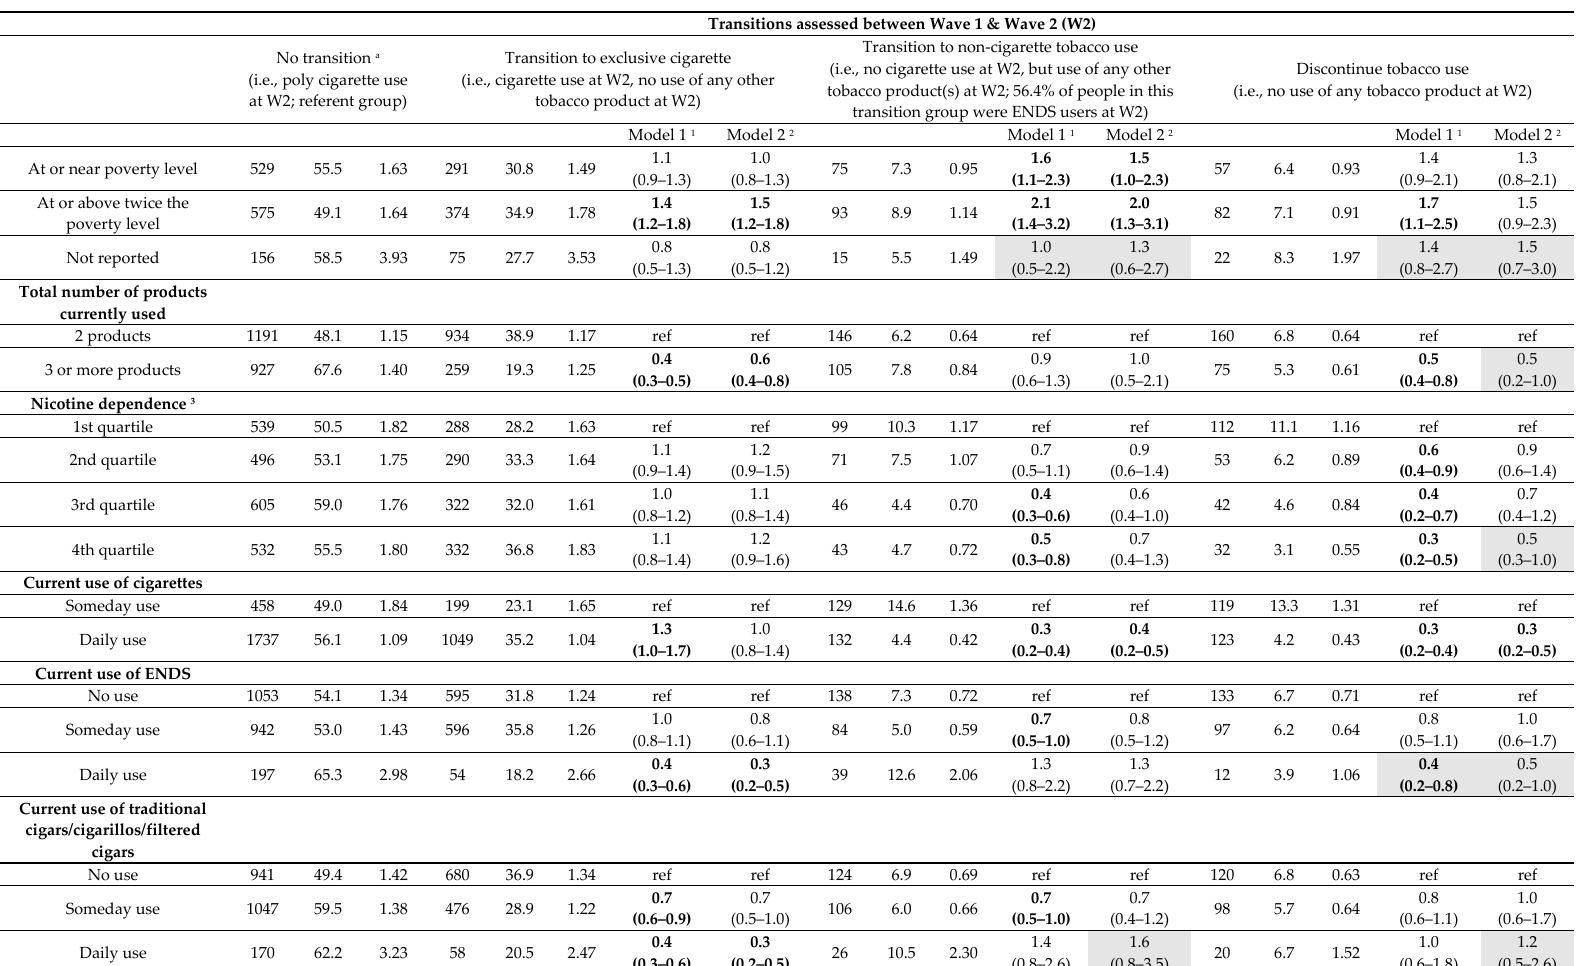
Table 4. Cont. Int. J. Environ. Res. Public Health 2018 , 15 , x 17 of